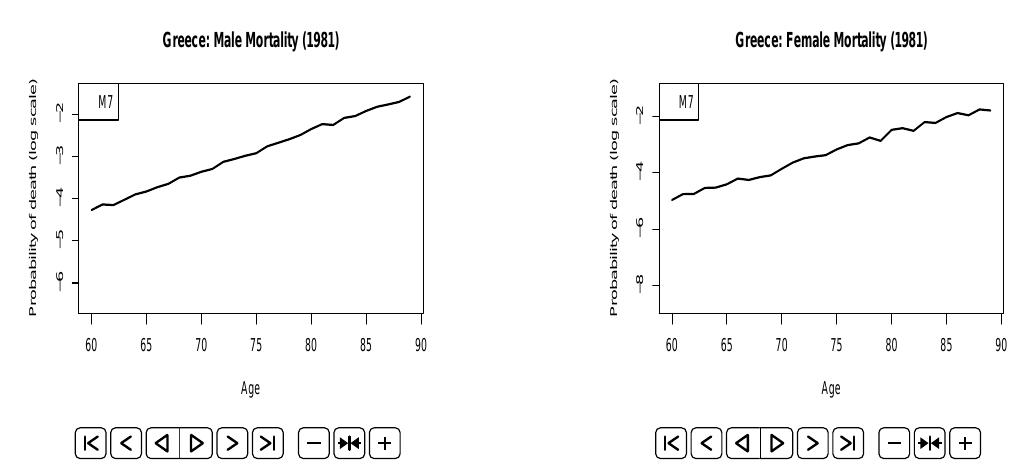
Figure A7. M 7 for males and